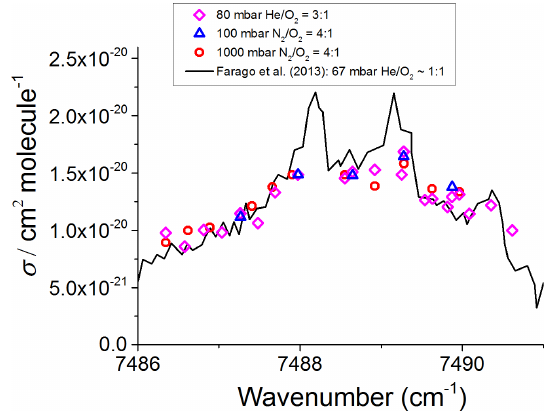
Figure 3. CH 3 O 2 absorption spectrum at 295K. The measured absorption spectrum scaled to the absolute cross section deter- mined at 7488cm − 1 using the kinetics of the CH 3 O 2 decay mon- itored using CRDS (Sect. 3.2 below). The black line represents the CH 3 O 2 spectrum measured by Faragó et al. (2013) at 67mbar He / O 2 ∼ 1 : 1 but with the absolute cross section scaled to reflect the recent update reported by Fittschen (2019) giving σ 2 . 2 × 10 − 20 cm 2 molecule − 1